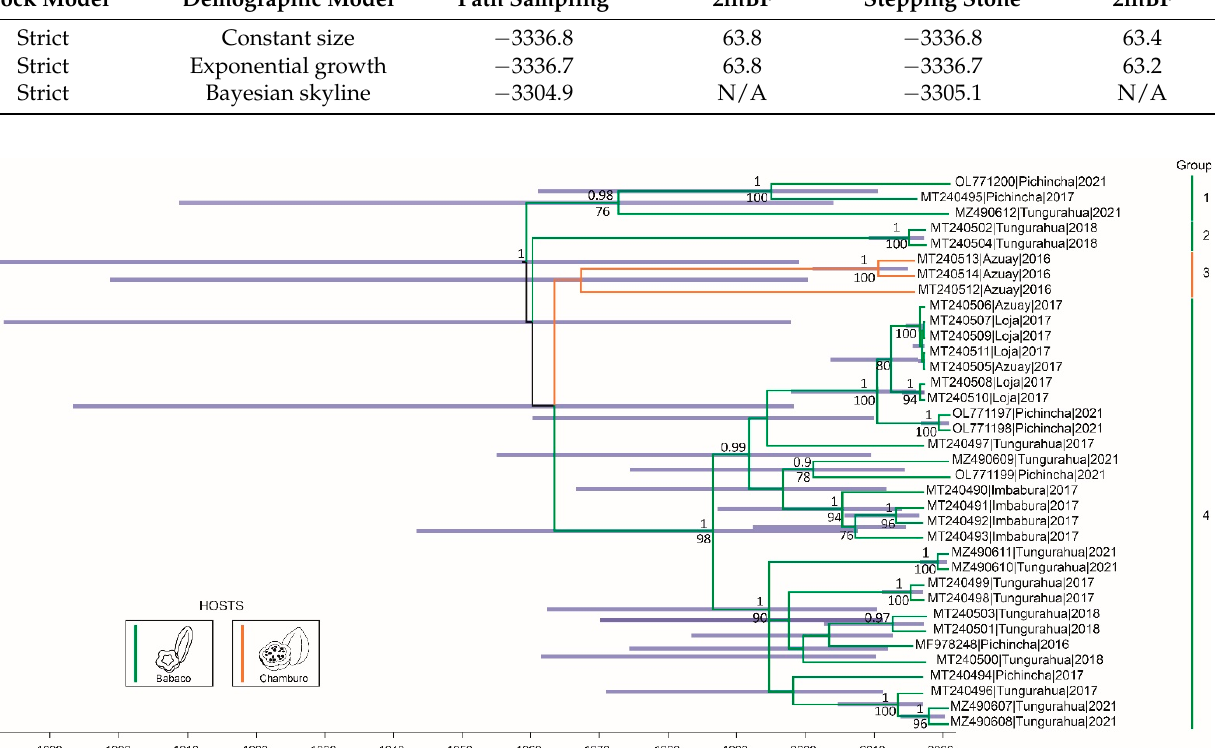
Table 1. Marginal likelihood score calculated by path sampling and stepping-stone methods for the strict molecular clock and demographic models tested for the Bayesian inference of babaco mosaic virus coat protein phylogeny.